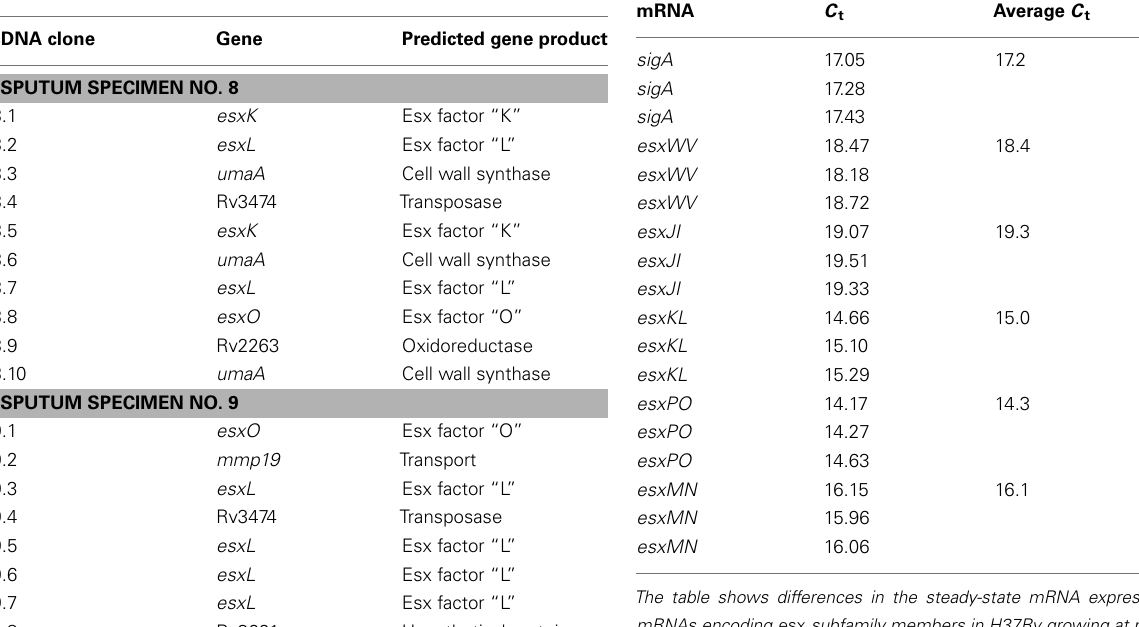
Table 2 | Mycobacterium tuberculosis esx transcripts identified by novel targeted SCOTS in patient specimens 8 and 9.